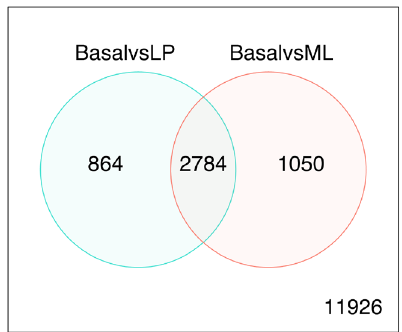
Figure 5. Venn diagram showing the number of genes DE in the comparison between basal versus LP only (left), basal versus ML only (right), and the number of genes that are DE in both comparisons (center). The number of genes that are not DE in either comparison are marked in the